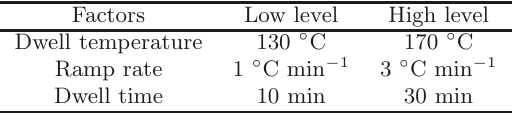
Table 1. Factors for the design of